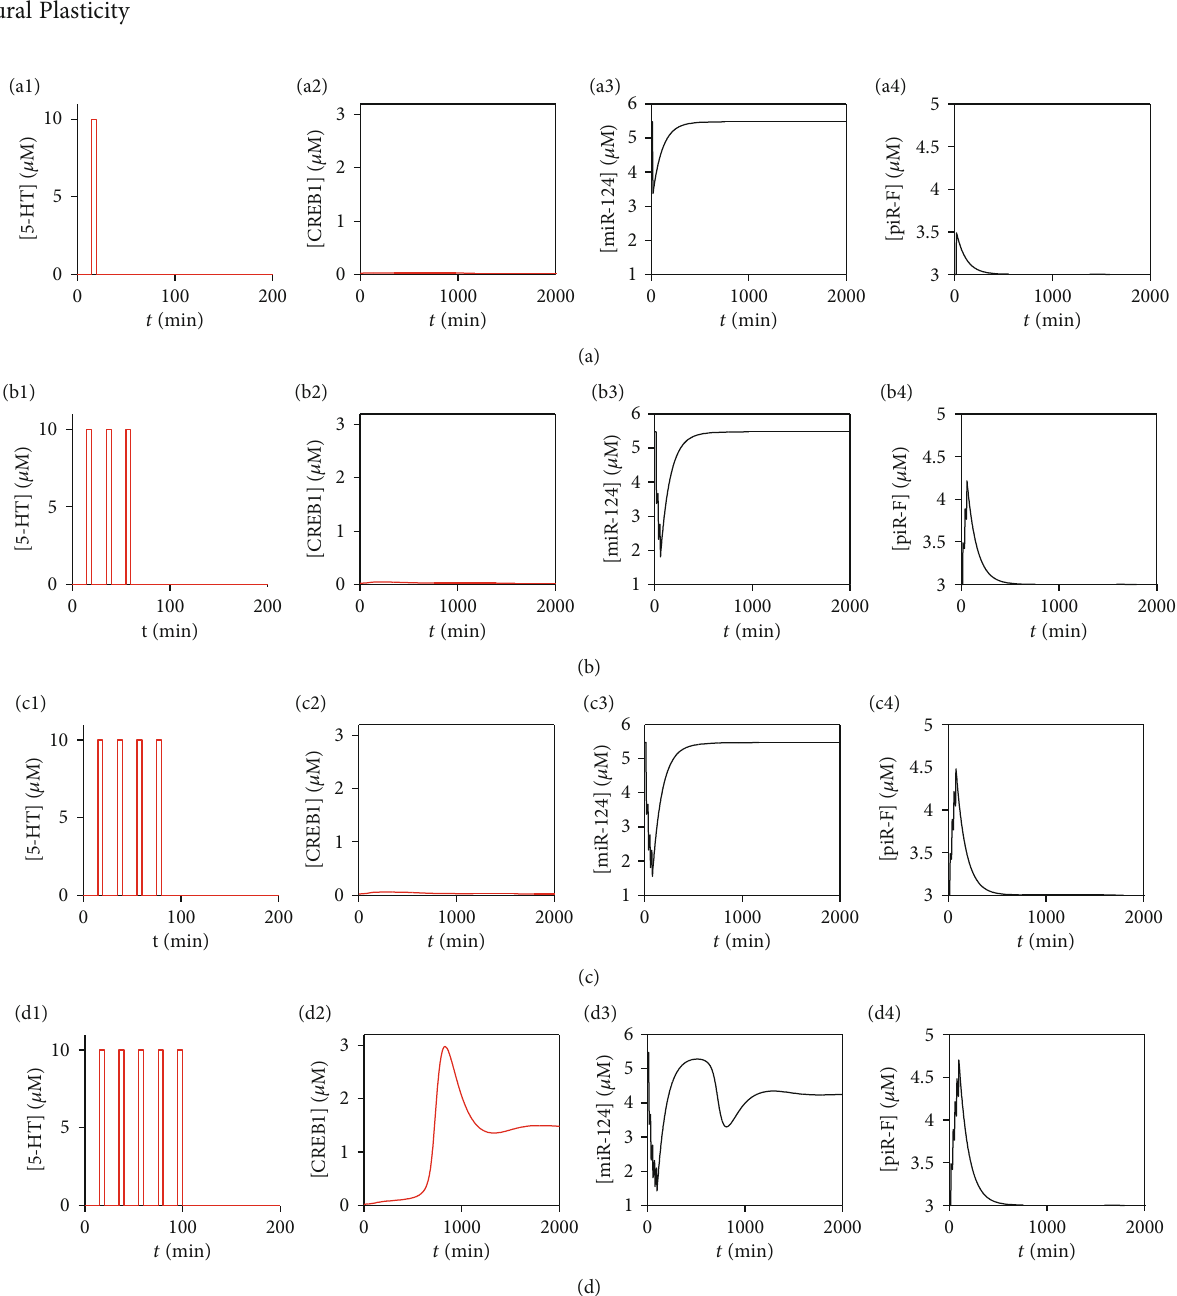
Figure 5: Time courses of [CREB1] (the second column), [miR-124] (the third column), and [piR-F] (the fourth column) under di ff erent stimulus protocols (the fi rst column): one pulse (a), three pulses (b), four pulses (c), and fi ve pulses (d) of 10 μ M stimulus for 5 min and the interpulse interval (from the end of one pulse to the onset of the next) of 15min. Other parameter values are given in Table